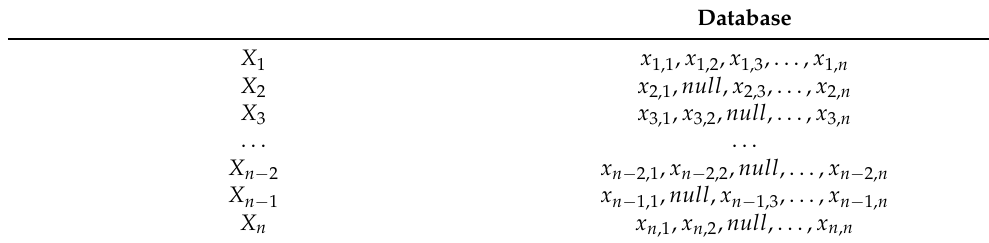
Table 3. A database example with missing values.